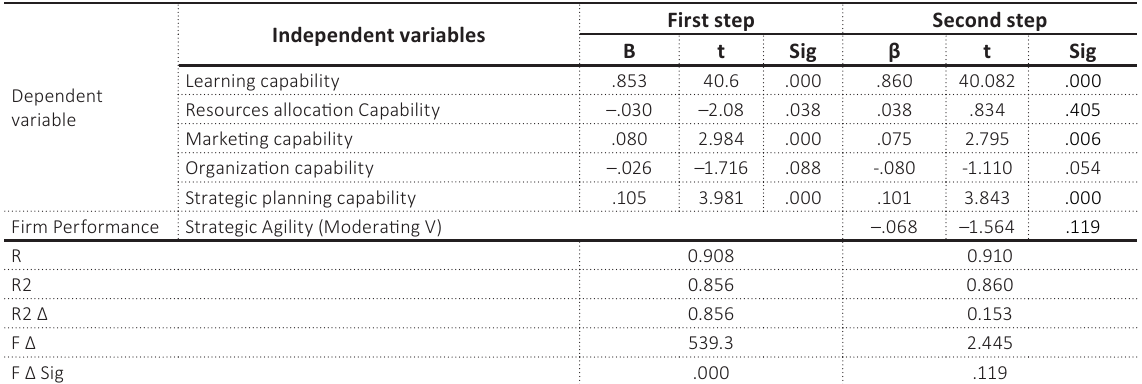
Table 6. Multiple hierarchical regression